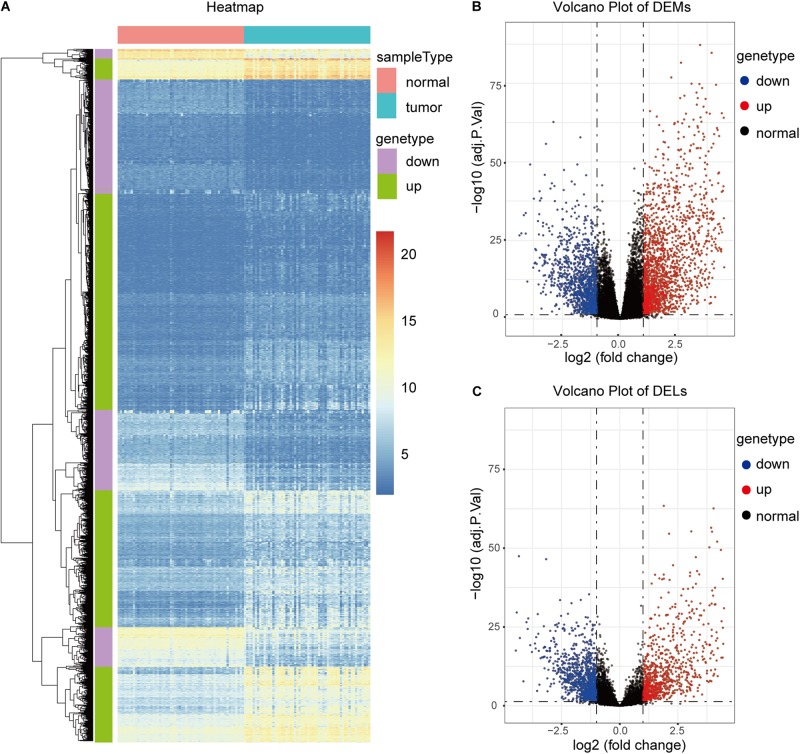
Identification of DEGs in the TCGA58 dataset. (A) Heatmap of the top 2,000 DEGs. (B,C) Volcano plots of DEMs and DELs.